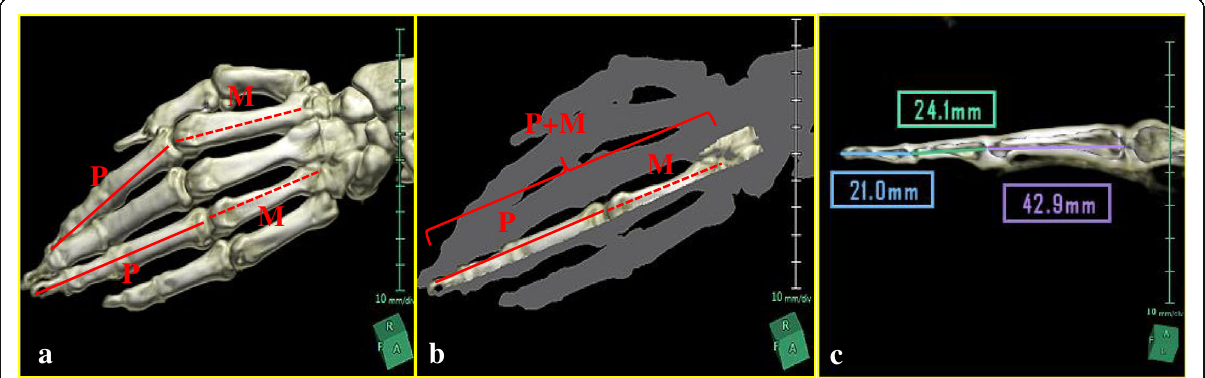
Fig. 1 Measurements of finger lengths by computed tomography and the computer analyzer system. Red solid line: P, the total length of the distal, middle, and proximal phalanges. Red broken line: M, the length of the metacarpal bones in the longitudinal direction. a - c The figures show method for measurements. P + M : the total of lengths P and